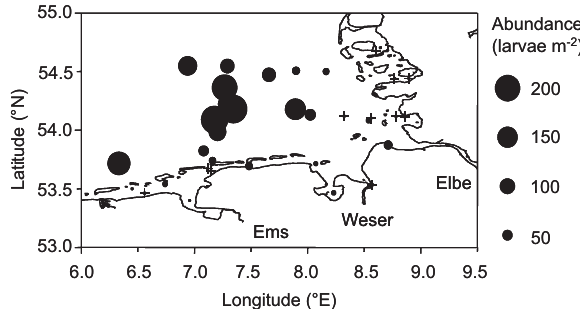
F IG . 3. – Abundance (circles, individuals m -2 ) of clupeiform larvae, including unidentified clupeids, sardine, sprat and anchovy, at dif- ferent sampling stations in the German Bight. Crosses indicate sta- tions where clupeiform larvae were not captured.